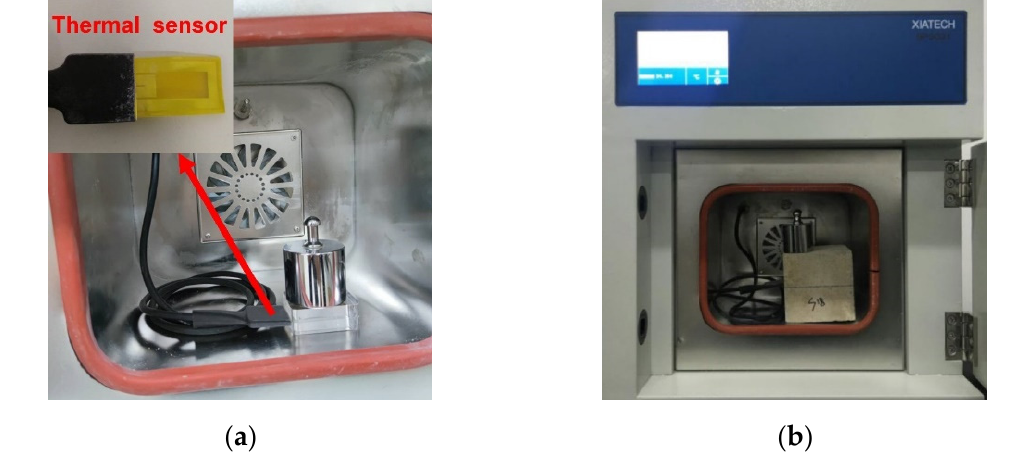
Figure 4. ( a ) Automatic test instrument for measuring thermal conductivity with hot wire method; ( b ) Thermal conductivity test of NAAC. ( b ) Thermal conductivity test of